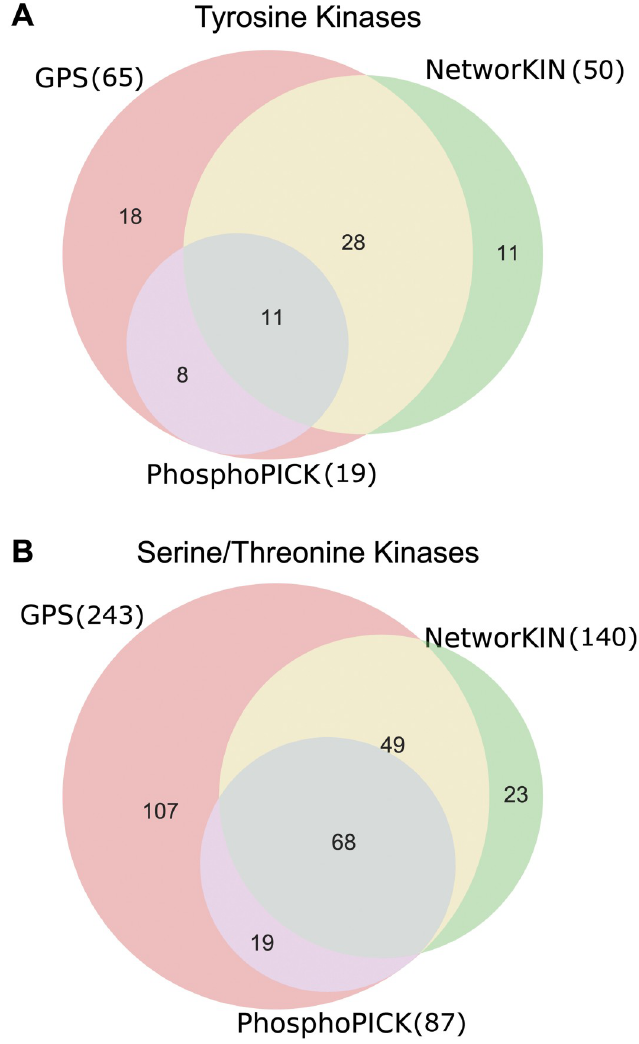
Fig 1. Comparison of the number of kinases in each predictive algorithm by kinase group. A: Tyrosine kinases. B: Serine/threonine